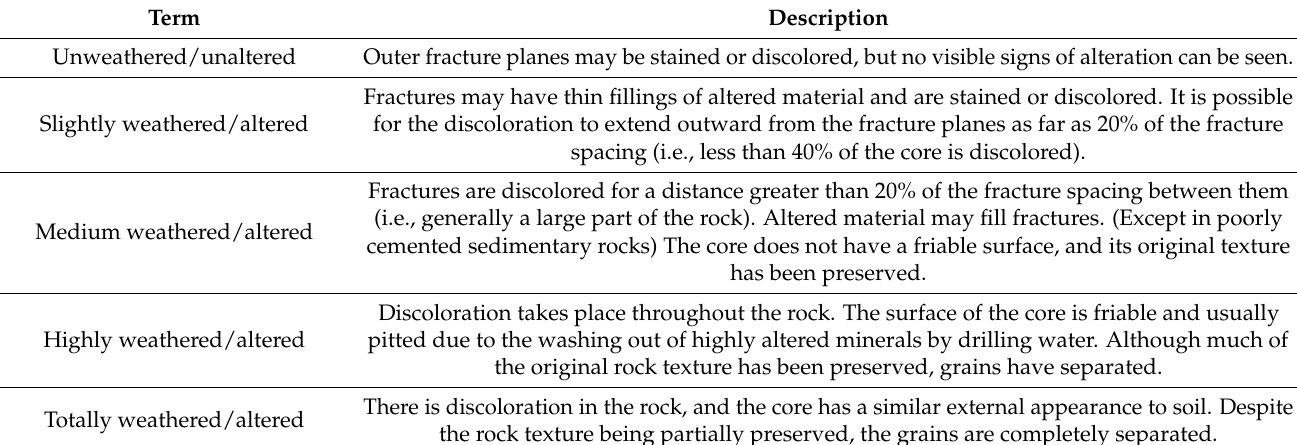
Table 5. Degree of weathering of the rock